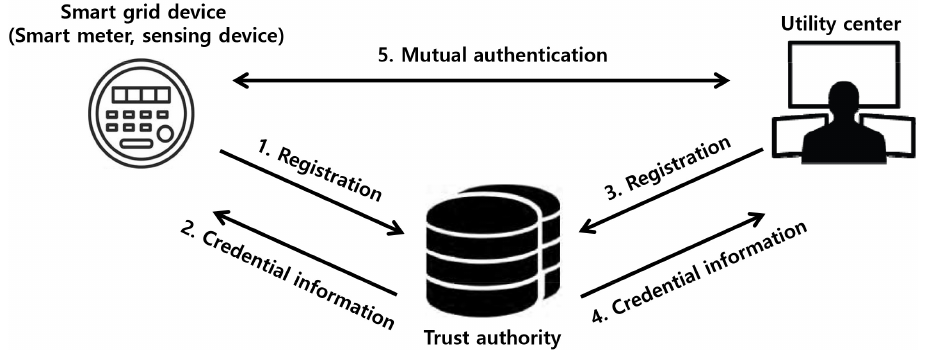
Figure 2. Authentication process of the proposed scheme in smart grid